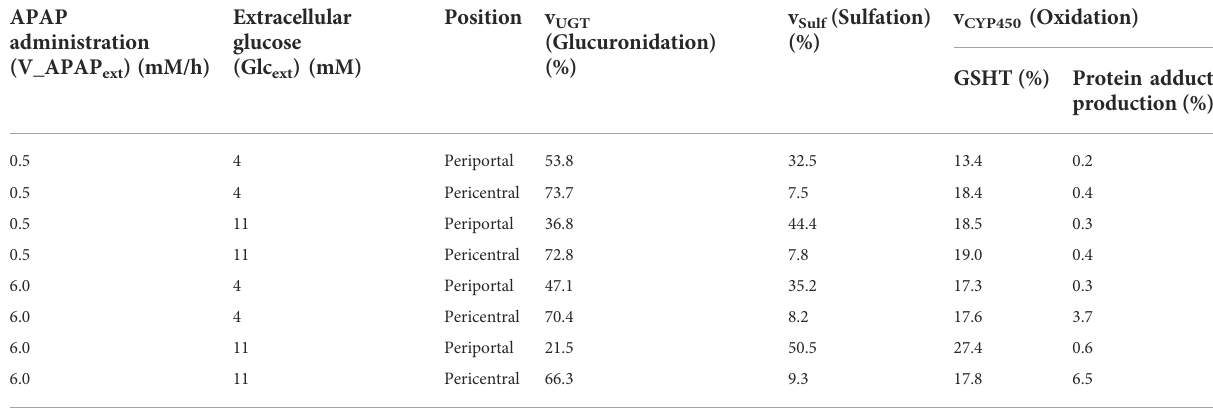
TABLE 1 Relative contribution of APAP metabolic pathways in healthy